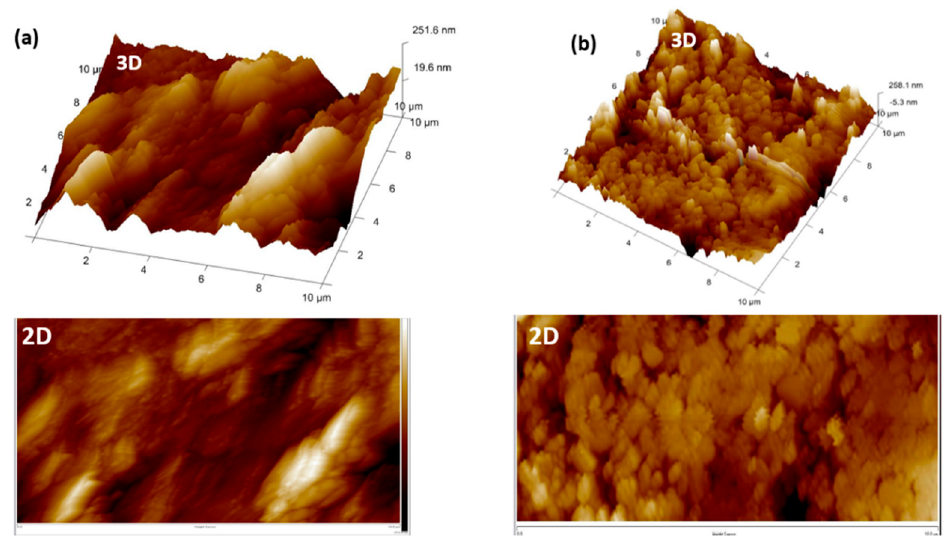
Figure 5. Atomic force microscopy (AFM) images of ( a ) GO ( b ) GO-PANI nanocomposite.